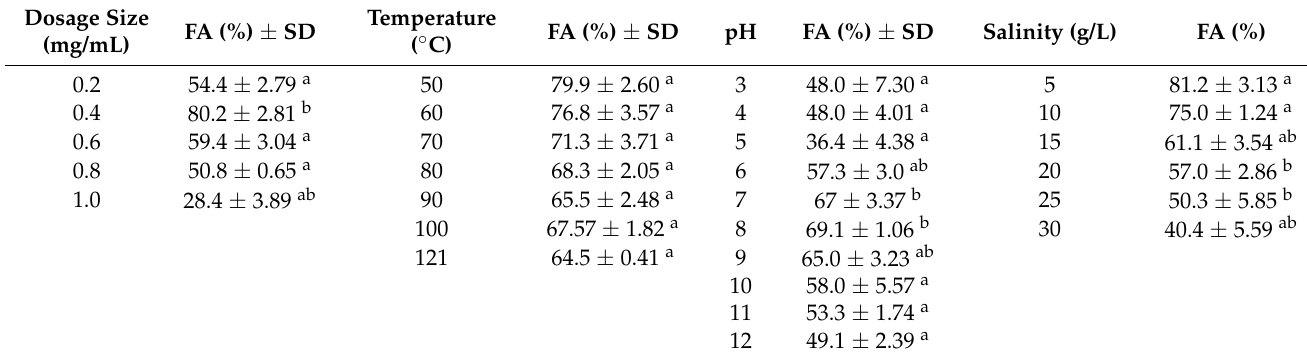
Table 2. Effect of dosage, temperature, pH, and salinity on flocculating activity of a purified bioflocculant.